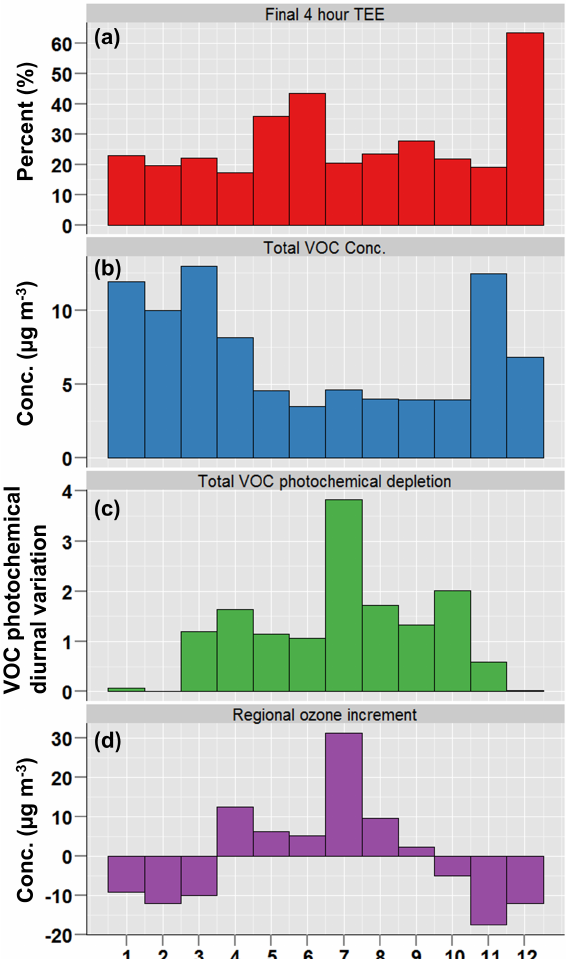
Figure 11. Summary of variables relevant to the assessment of the effect of variation in the proportion of emissions accumulated close (temporally) to the monitoring site: (a) the final 4h TEE metric, i.e. the proportion of the TEE emitted into the air mass during the 4h prior to arrival at the site (defined in Sect. 3.3.2), (b) monthly- average sum of measured VOCs, (c) monthly-average sum of VOC diurnal photochemical depletion, (d) monthly maximum difference between hemispheric background concentrations and regional back- ground concentrations (a positive value indicates additional regional O 3 production).